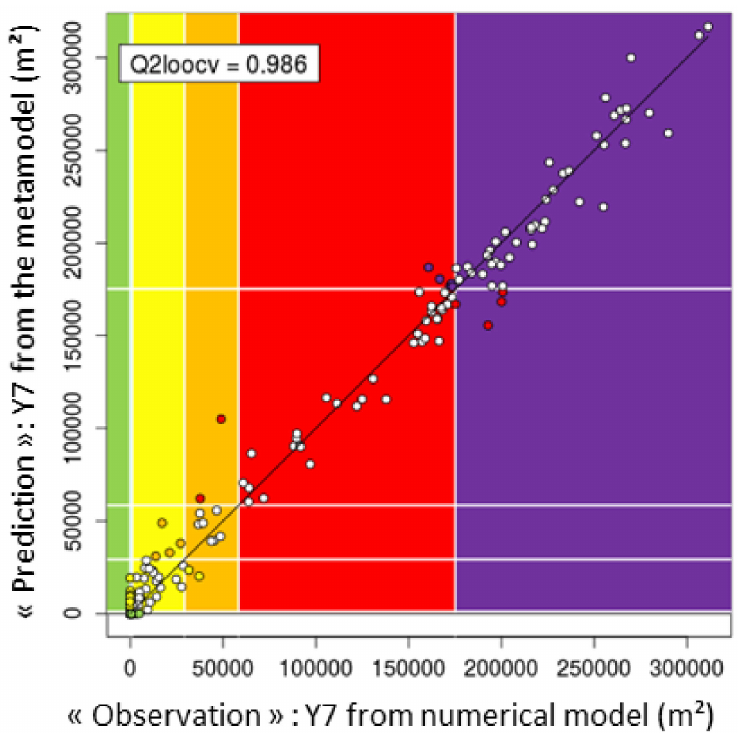
Figure 10. Cross-validation of the Y 7 metamodel: comparison between the observations (numerically calculated Y num values) and the predictions of the GP-based metamodels. The predictive capability is measured by Q 2 (the closer Q 2 is to one, the higher the prediction quality). The colour scale corresponds to the colour scale of indicator I 1 (except that there is no “blue” class here). White dots indicate a correct class prediction; the remaining points are coloured according to the predicted